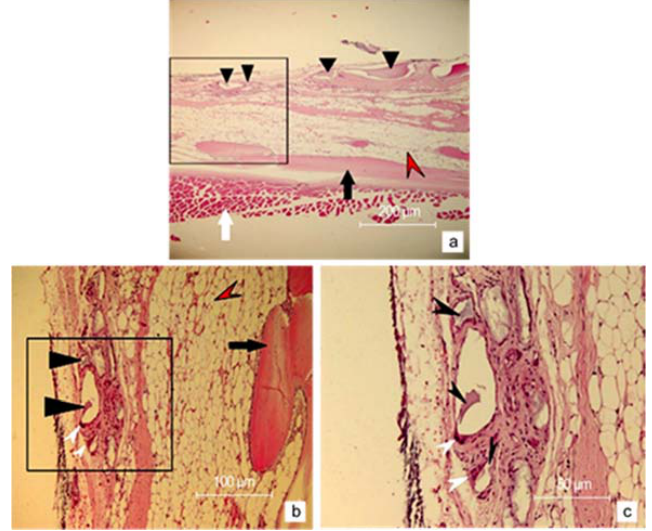
Figure 8. ( a ) Microscopic aspects of HAp implant two months after implantation, as revealed by hematoxilin eosin staining (the magnification is 10×); ( b ) Detailed image of the inset in figure (a) at 20× magnification; ( c ) Detailed image of the inset in figure (b) at 40× magnification. Black arrowheads mark HAp implant. Black arrows mark the osseous tissue. White arrowheads mark osteoclasts. White arrows mark the inferior rectus muscle. Red arrowheads mark the adipose tissue adjacent to bone structure.